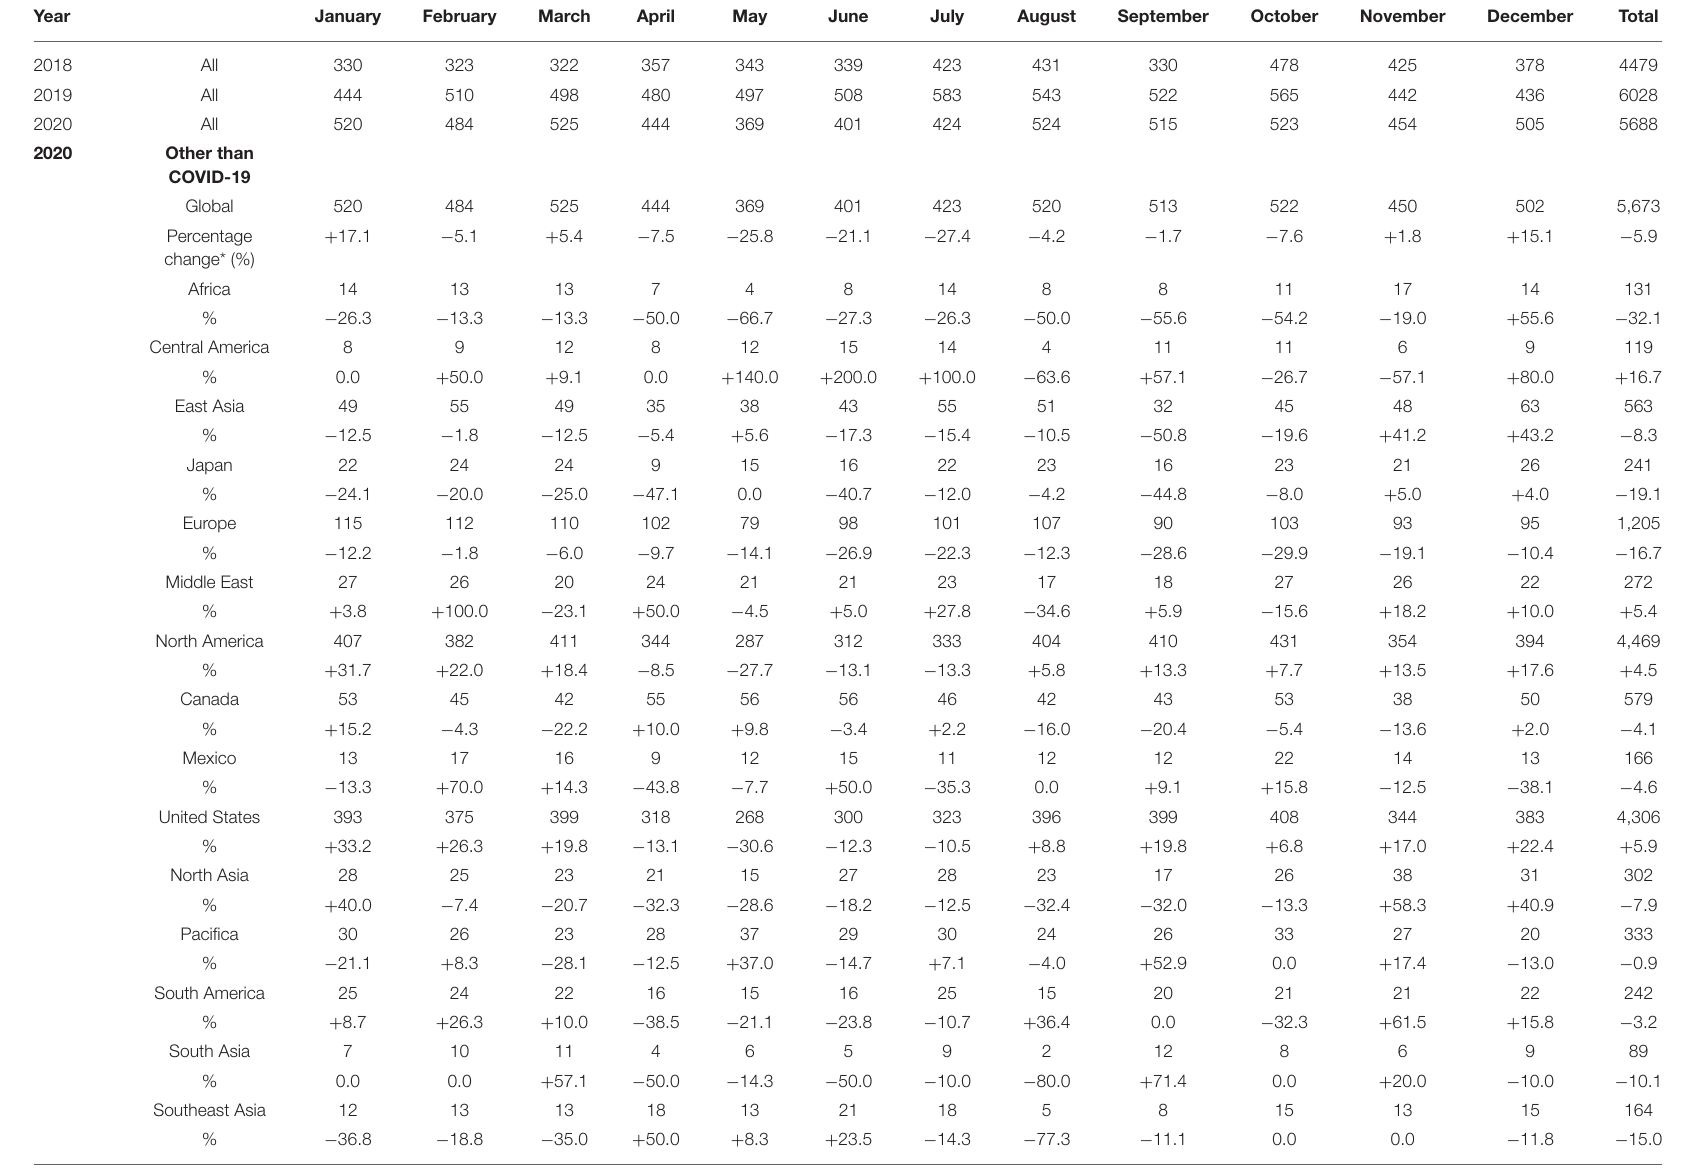
TABLE 2 | Number of clinical trials with